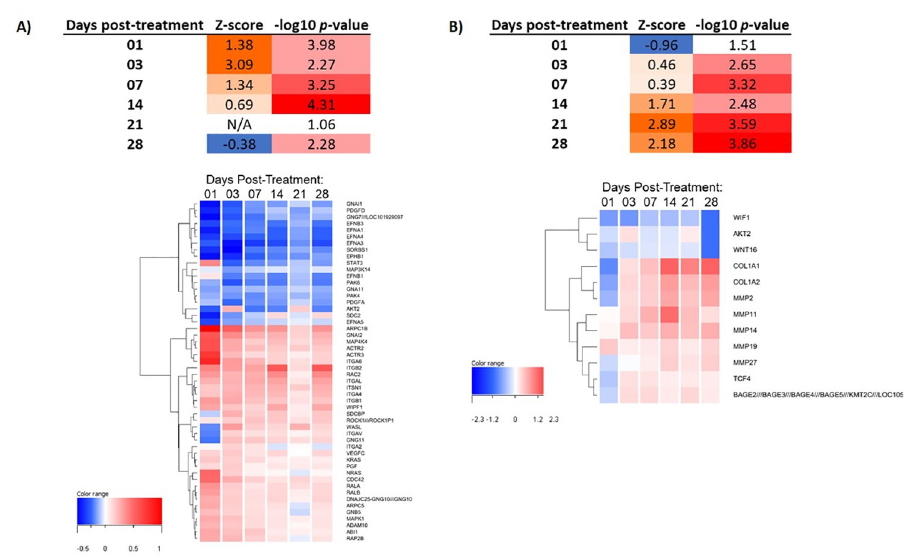
Fig 2. Single laser resurfacing treatment stimulates signaling pathways associated with wound repair. A) Activation of ephrin receptor signaling at early (days 1–3) time points following single laser resurfacing treatment. Dendrogram shows clustering of genes (n = 52) involved in the ephrin receptor signaling pathway by average log 2 fold change compared to baseline untreated samples. B) Activation of the HOTAIR regulatory pathway at mid-to-late (days 14–28) time points following single laser resurfacing treatment. Dendrogram shows clustering of genes (n = 12) involved in the HOTAIR regulatory pathway by average log 2 fold change compared to baseline untreated samples. Color scales for z-scores indicate predicted low/inhibition (blue) to high/activation (orange) states for each pathway at a given time point. Color scale for–log 10 p -value reflect low (white) to high (red) significance for each pathway at a given time point.